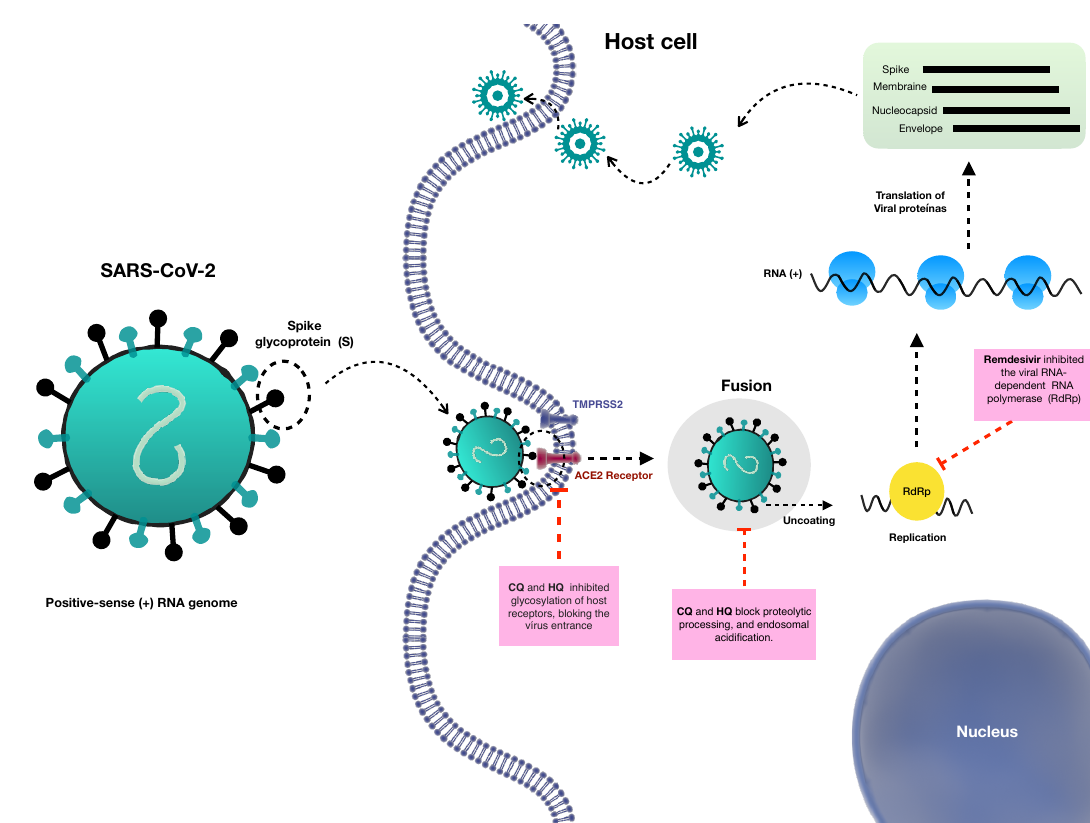
Figure 2. Therapeutic approaches in clinical test for COVID-19. SARS-CoV-2 model of infection and Remdesivir, Chloroquine and Hydroxychloroquine mechanisms